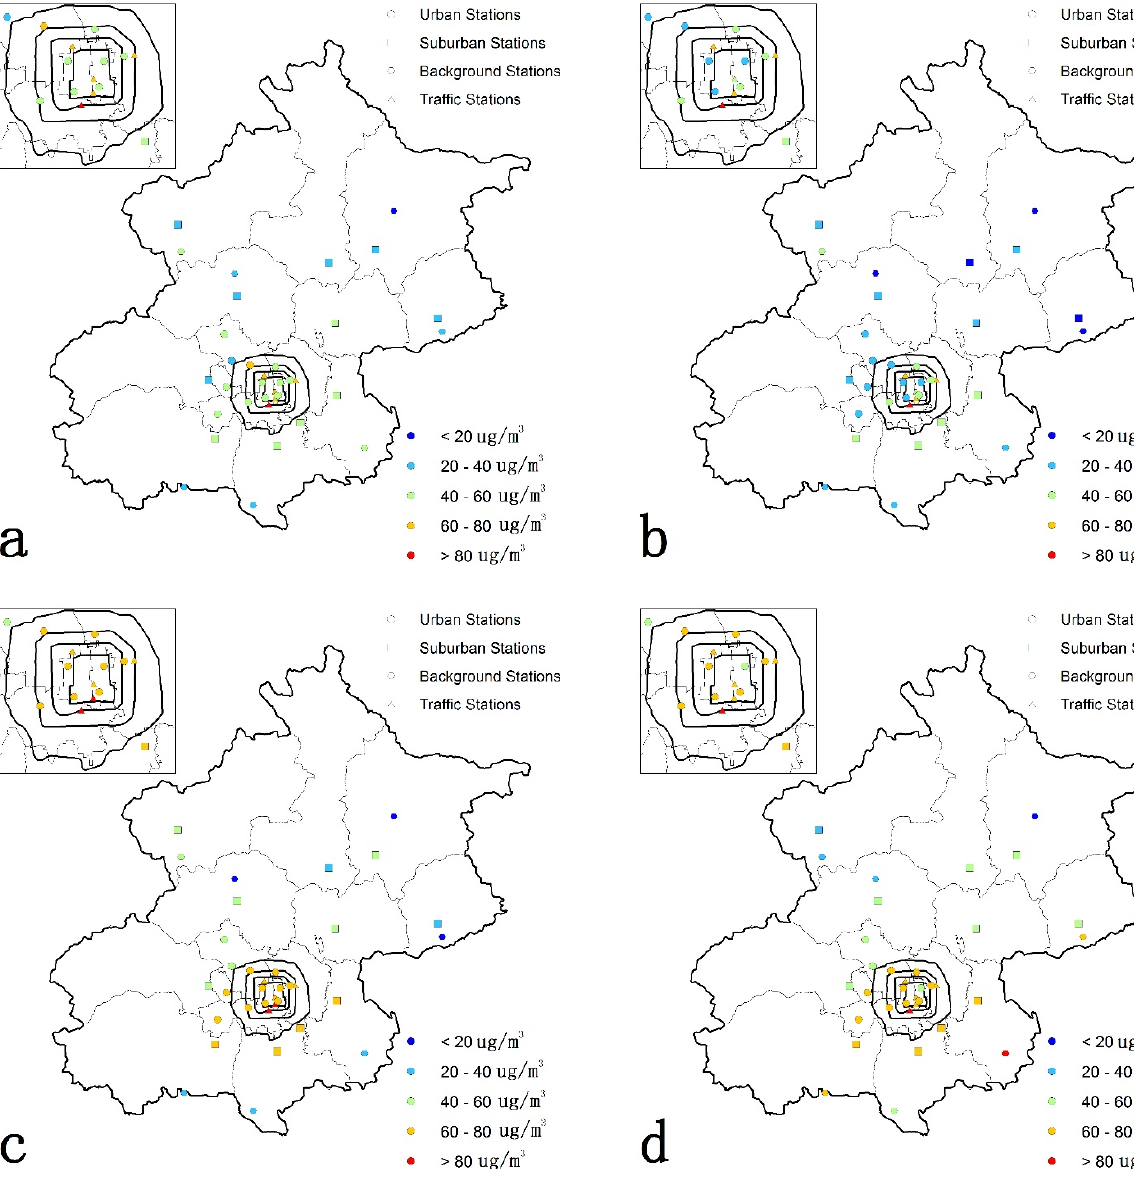
Figure 10. Seasonal variations of NO 2 concentrations for the 35 air quality monitoring stations (( a ) spring; ( b ) summer; ( c ) autumn; ( d )